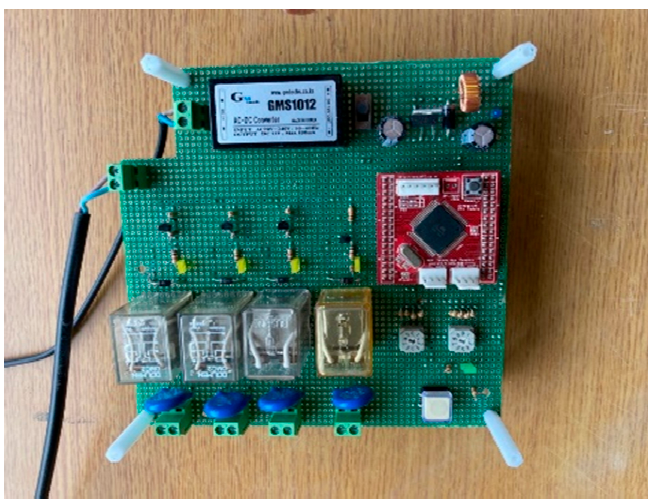
Figure 4. Power relator used for container 3.